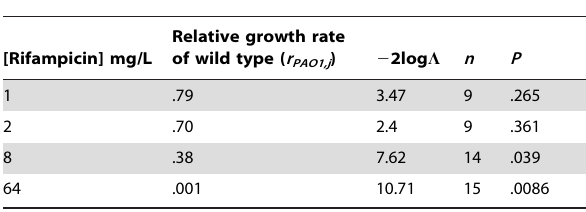
Table 2. Testing the exponential distribution.